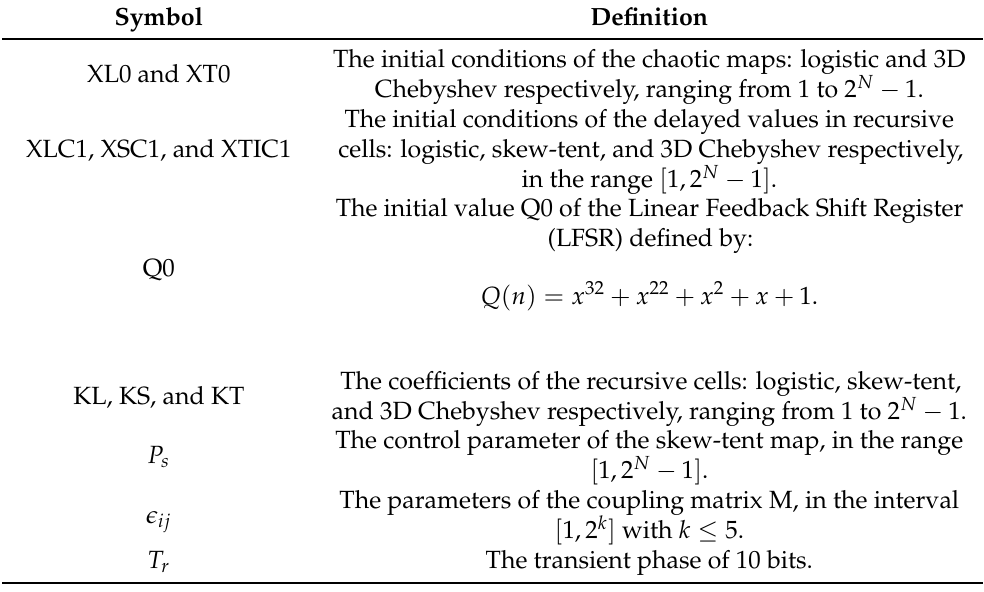
Table 1. Composition of the secret key K. Symbol Definition The initial conditions of the chaotic maps: logistic and 3D XL0 and XT0 Chebyshev respectively, ranging from 1 to 2 N − 1. The initial conditions of the delayed values in recursive XLC1, XSC1, and XTIC1 cells: logistic, skew-tent, and 3D Chebyshev respectively, in the range [ 1, 2 N − 1 ] . The initial value Q0 of the Linear Feedback Shift Register (LFSR) defined by: Q0 Q ( n ) = x 32 + x 22 + x 2 + x + 1.